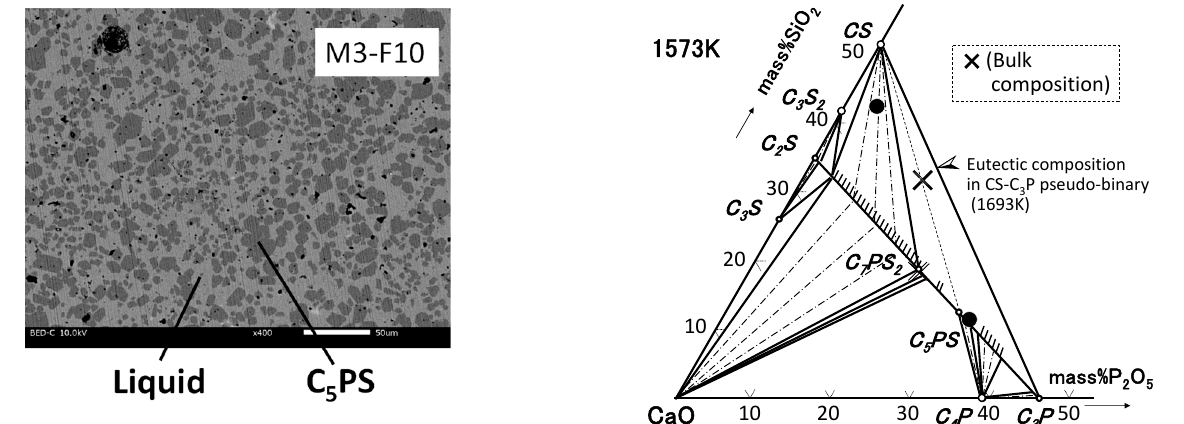
Figure 10. SEM image of M3-F5 (5mass% Fe 2 O 3 ) ( left ) and the phase composition projected on an